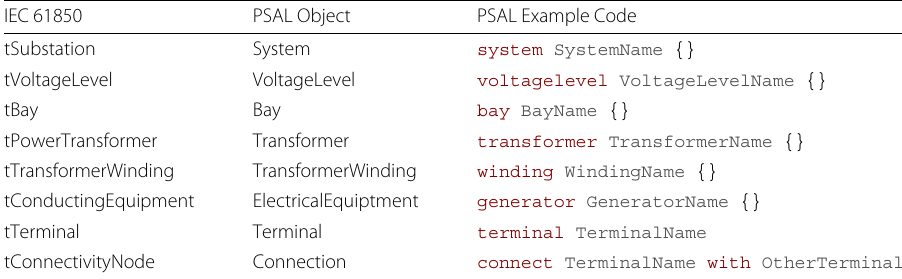
Table 1 Mapping parts of the IEC 61850 substation section into PSAL